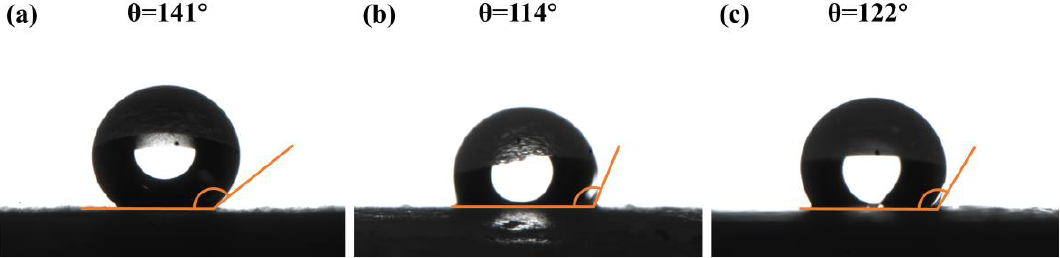
Figure 5. The contact angles of ( a ) the MSA, ( b ) paraffin and ( c ) paraffin/MSA composites. The FTIR spectra of the MSA, paraffin and paraffin/MSA composites are shown in Figure 6. In all three spectra, the absorption bands at 3440 cm −1 and 1635 cm −1 , respectively, correspond to the stretching vibration of the О-Н bonds and the bending vibrations of water molecules [40]. The absorption peaks at the wavenumbers of 2956 cm −1 , 2890 cm −1 and 2848 cm −1 are caused by the stretching vibration of C-H bonds [30,35]. The peak at 720 cm −